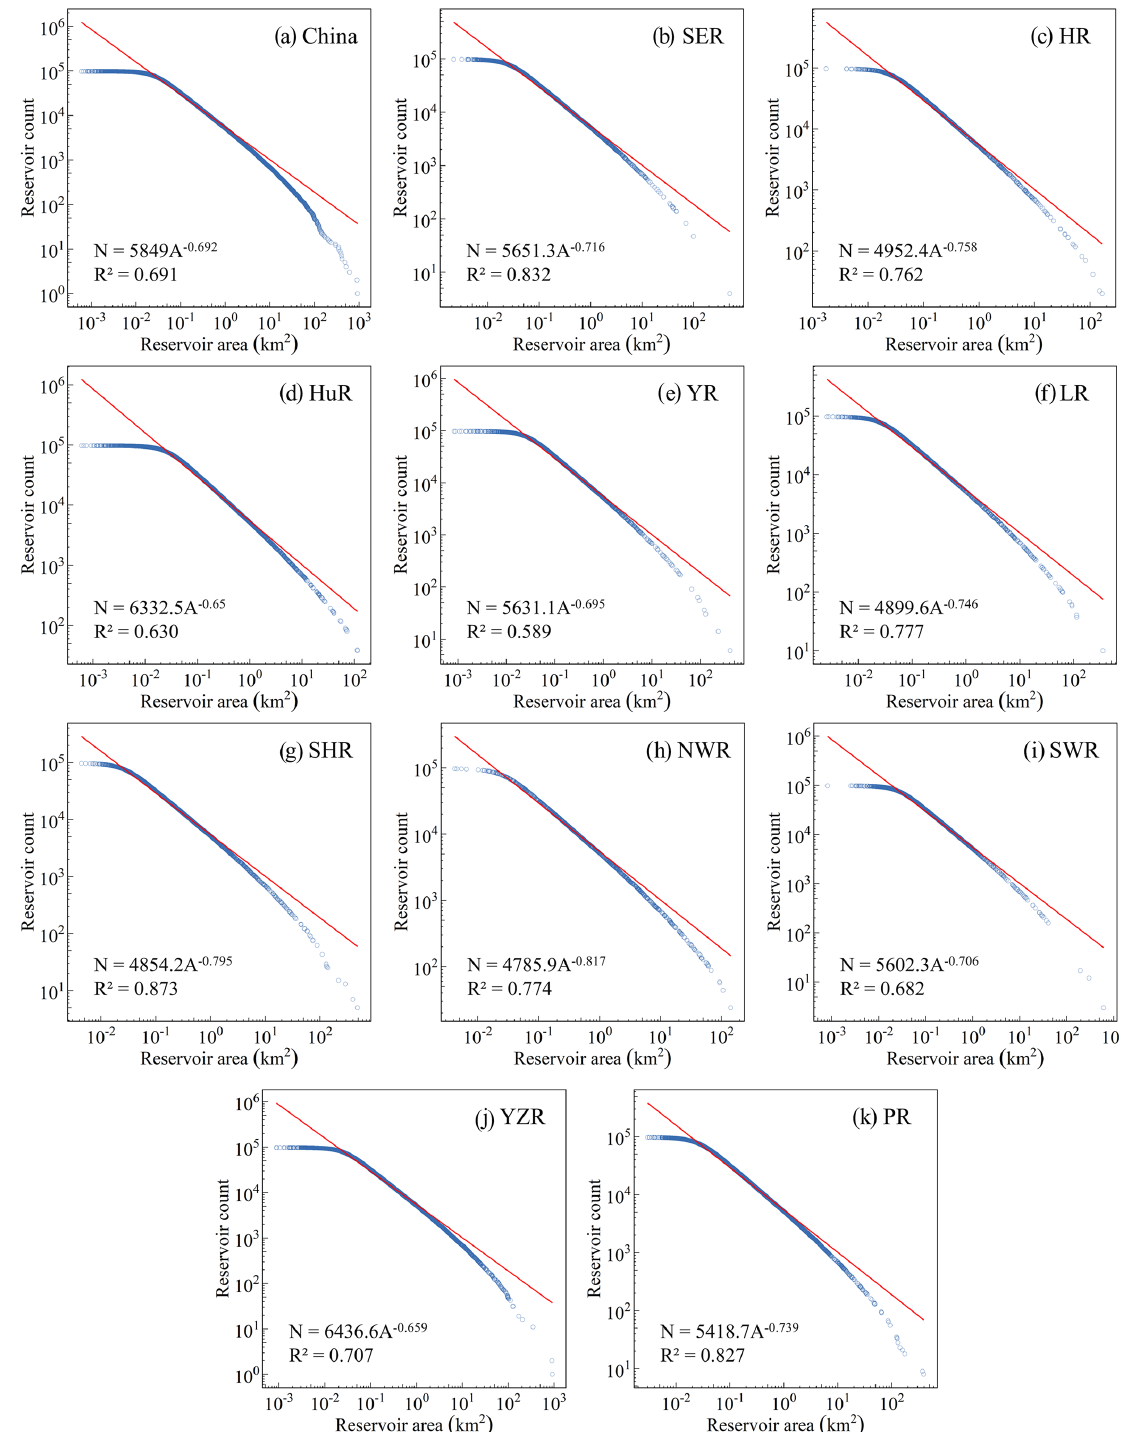
Figure 3. China reservoir area and count using a Pareto model. Distributions are plotted as the total number of reservoirs larger than a given surface area in China (a) and 10 first-level water resource divisions (b–k) . Blue circles intersecting the fitting lines represent the values